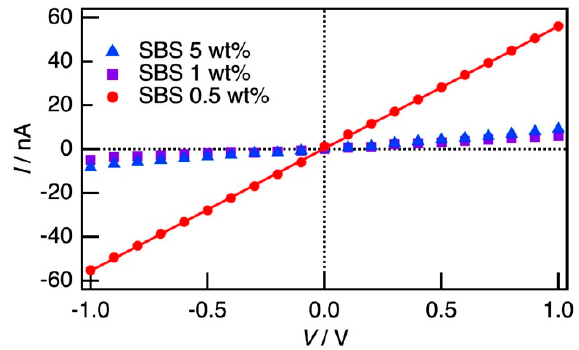
Figure 3. I - V characteristics of the SBS thin film loaded with the P3HT nanofiber.